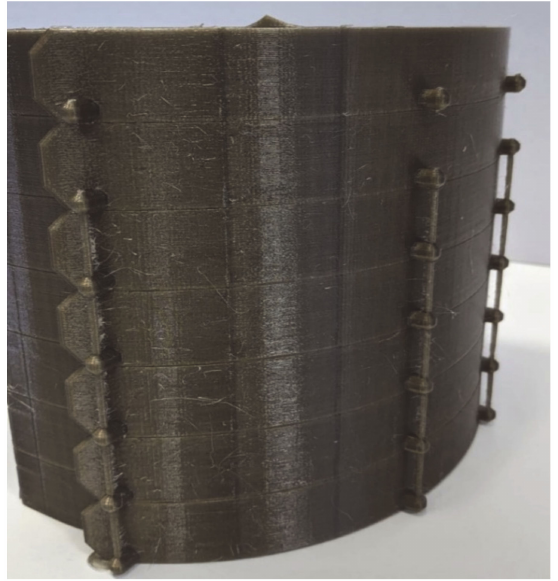
Figure 6. Image of 8 head bands that were bonded together and the surface shows stringing of the PETG